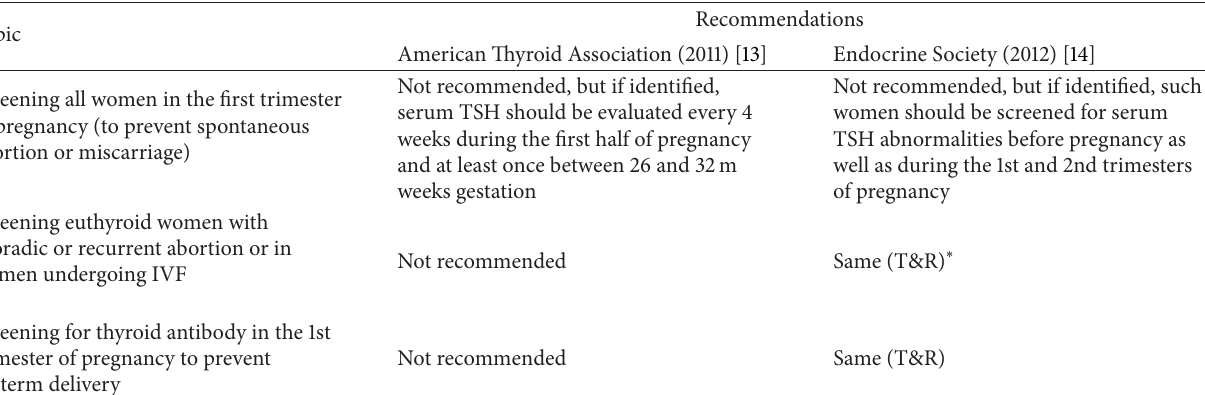
Table 1: Comparison of recommendations of the American Thyroid Association [13] and Endocrine Society [14] on the aspects of screening thyroid antibodies in pregnancy.